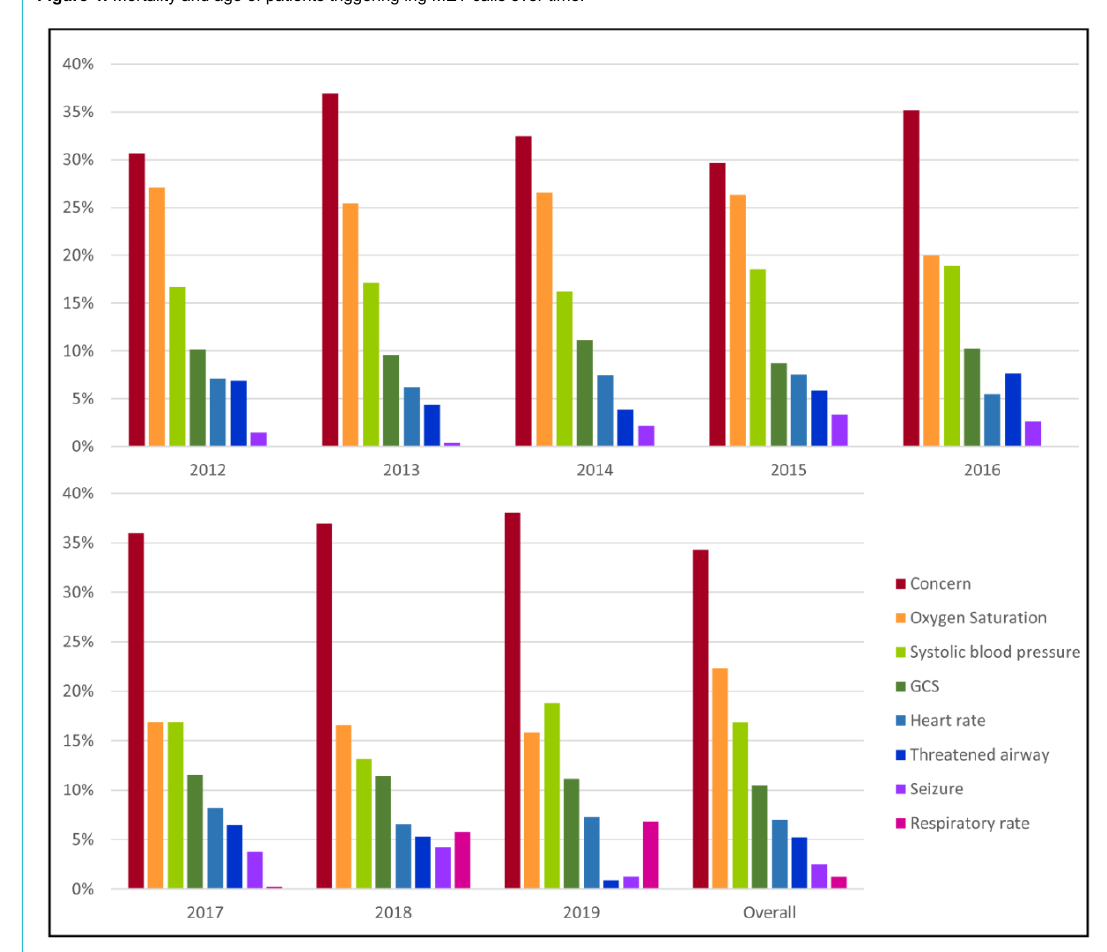
Figure 4: Mortality and age of patients triggering ing MET calls over